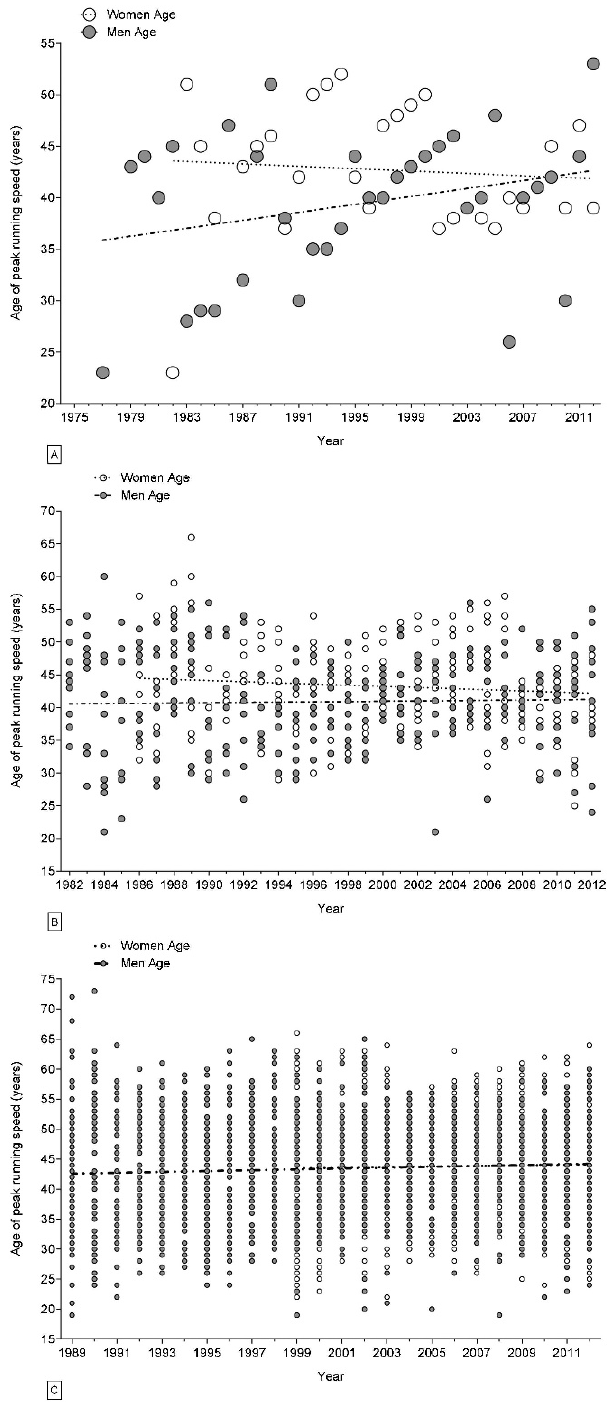
Figure 4 - Changes in the ages of peak running speed for the annual fastest (Panel A), the annual 10 fastest (Panel B) and the annual 100 fastest (Panel C) competitors (27) and in the 100-mile runs (8), the fastest finishers were master athletes, according to Raeburn’s definition. Our results are in agreement with Reaburn’s definition of master athletes. In 24-hour ultra-marathons, the male world elite athletes were, on average, 41 years old; consequently, master athletes have to be older. Therefore, our results